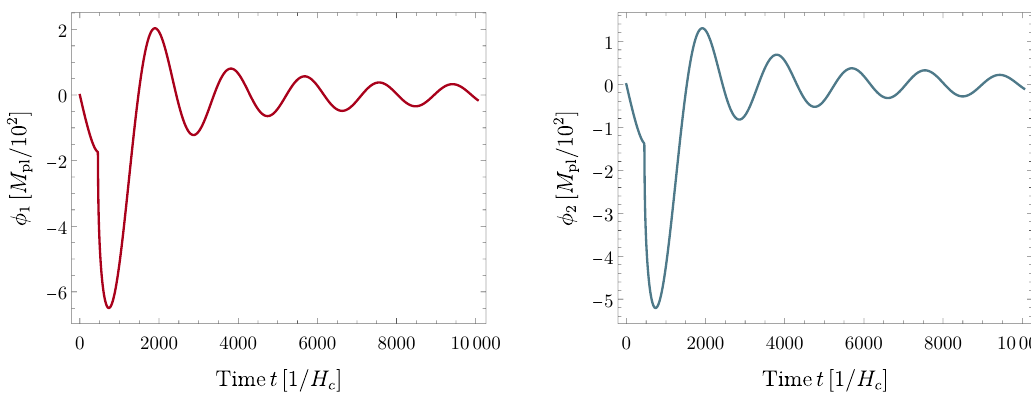
Figure 6 . Time evolution of φ 1 and φ 2 as function of the cosmic time t . Here H c ≡ H | φ = φ 6 . 1 × 10 12 GeV . The parameters are the same as figure